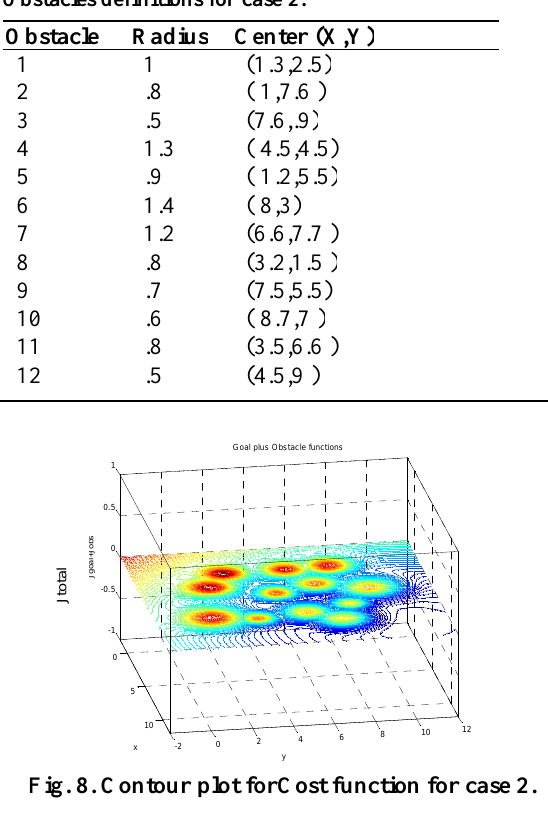
Obstacles definitions for case 2.